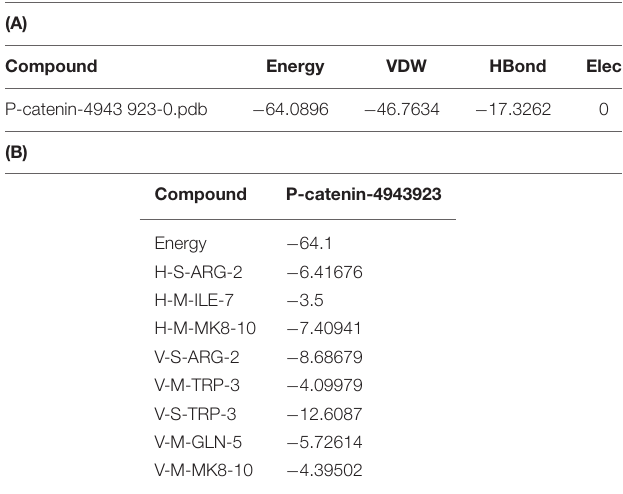
TABLE 1 | Table represented the fitness and Interaction values during the molecular docking of 3 DETS in to β -catenin.